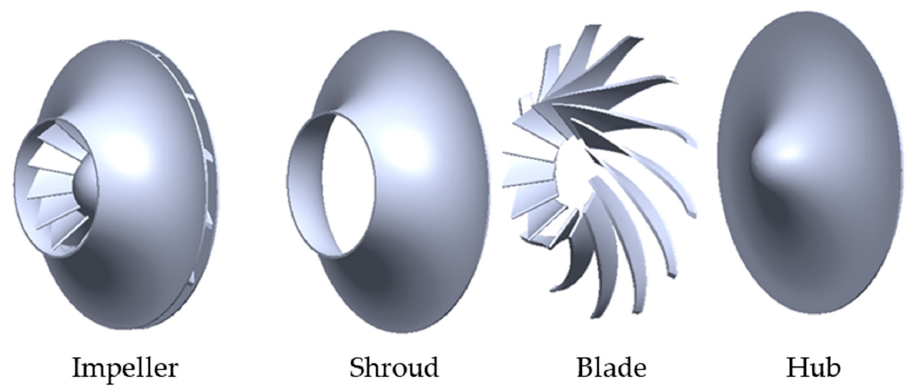
Figure 2. Exploded diagram of an impeller .